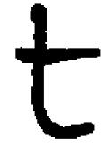
Fig. 2. One font of letter ‘t’ in the dataset